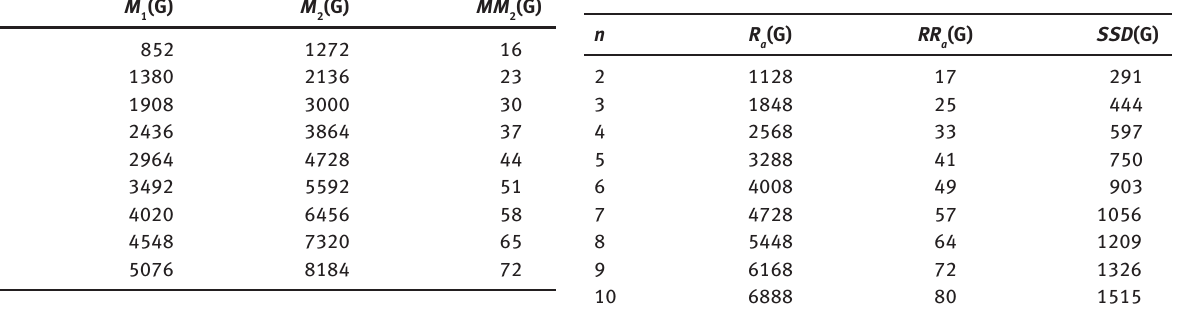
( n ) Table 9: Comparison among R 1